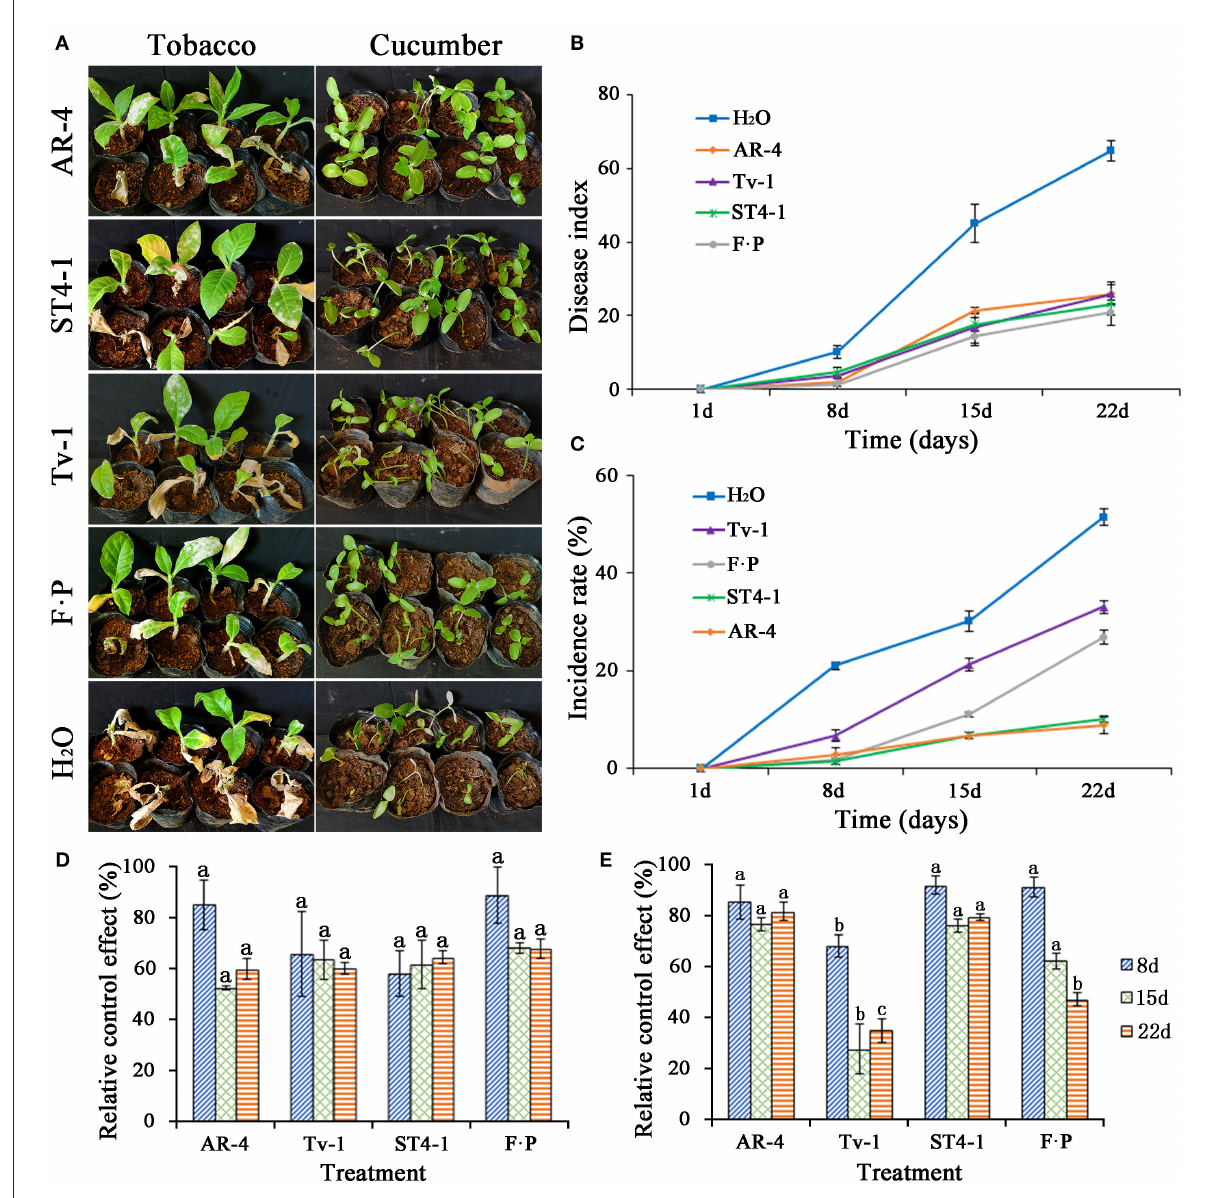
FIGURE3 Biocontrol effect of Trichoderma spp. on TBS disease and damping-off of cucumber seedlings. (A) Disease status of tobacco and cucumber seedlings after the application of Trichoderma spp. and control group; (B) disease index of TBS disease after the application of Trichoderma spp. and control group; (C) the incidence rate of damping-off of cucumber seedlings after the application of Trichoderma spp. and control group; (D) relative control effect of Trichoderma spp. and fluopicolide-propamocarb (FP) on TBS disease compared with water treatment; (E) relative control effect of Trichoderma spp. and fluopicolide-propamocarb (FP) on damping-off of cucumber seedlings compared with water treatment.